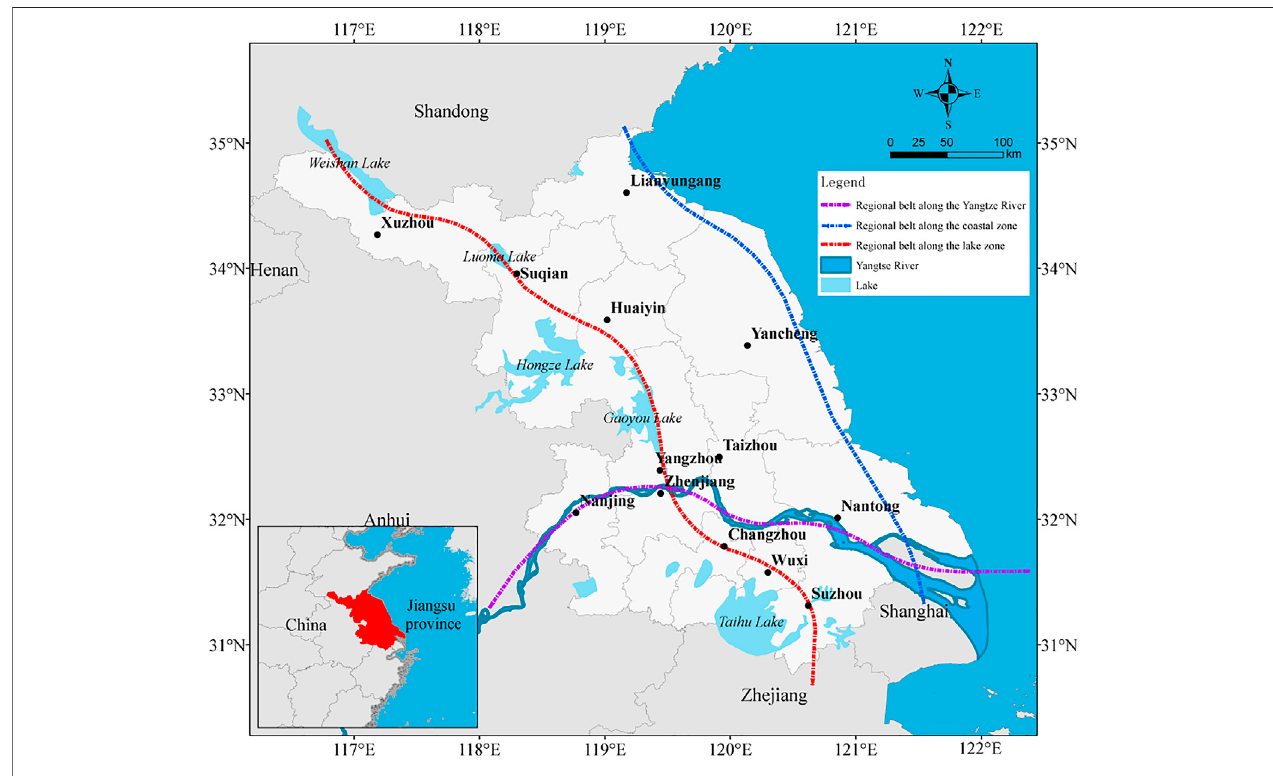
FIGURE 1 | Location of jiangsu province in